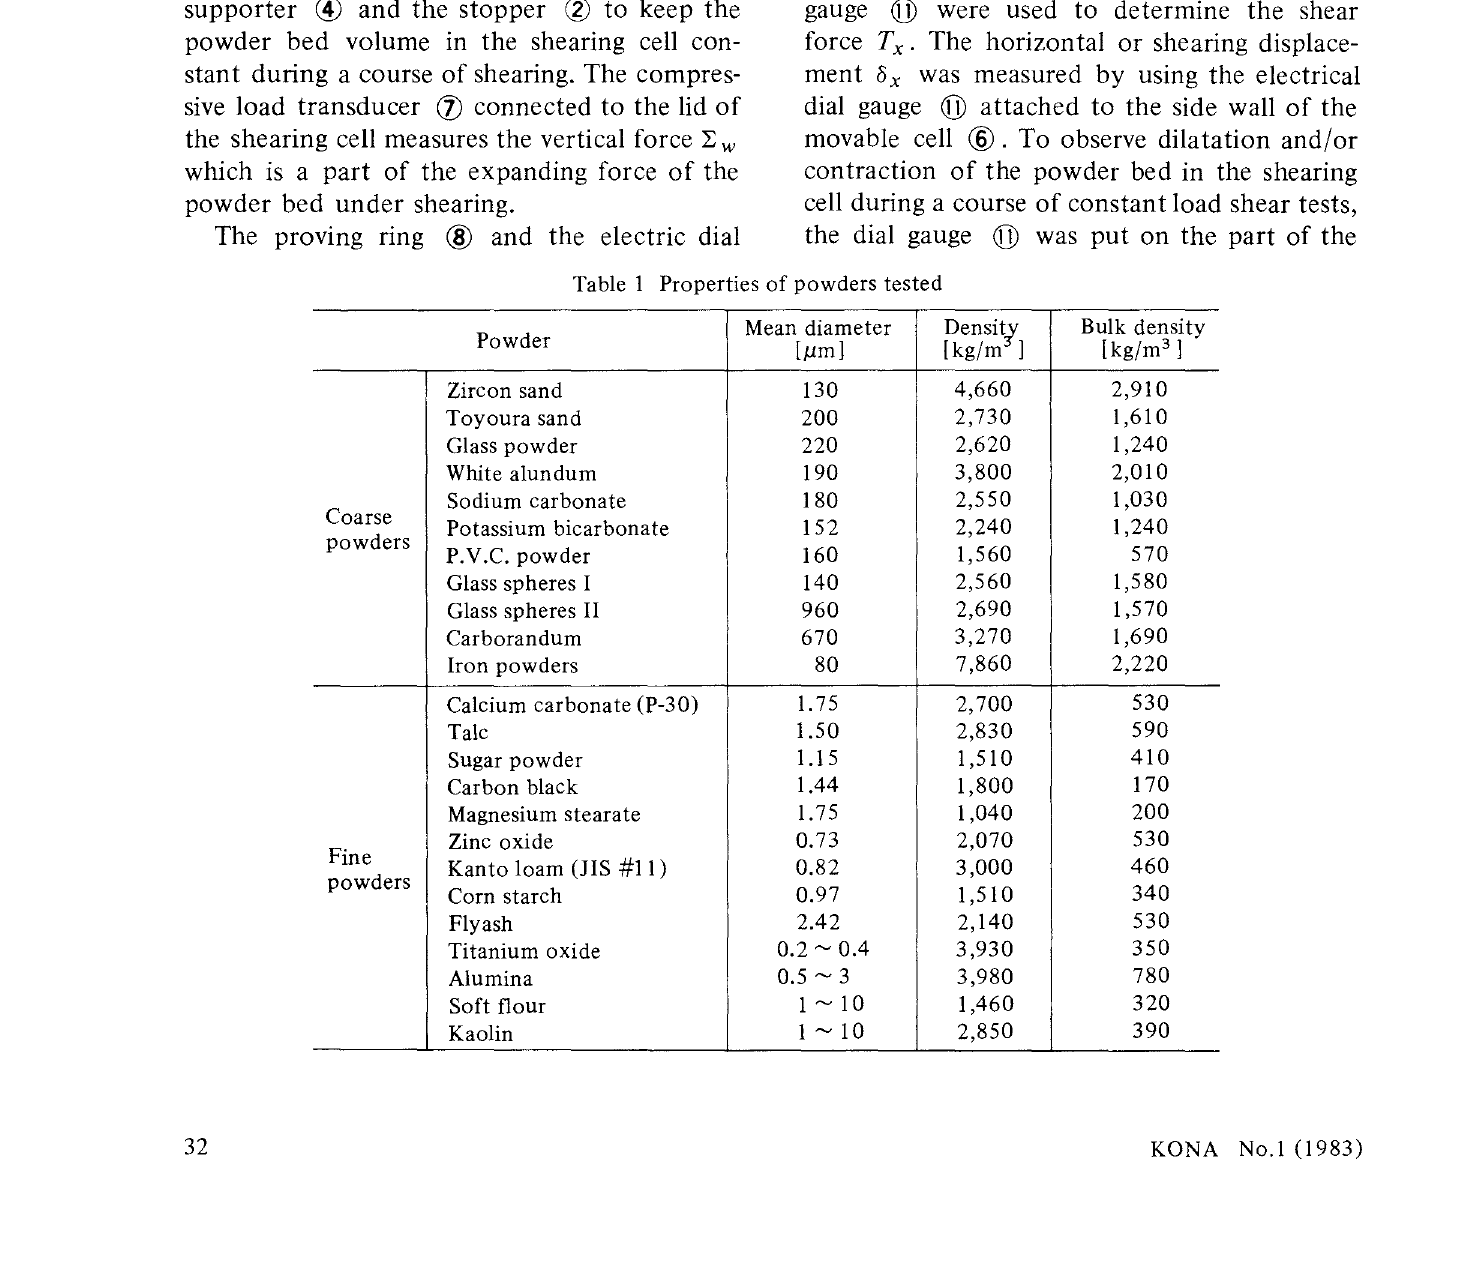
Fig. 4 Direct shear tester